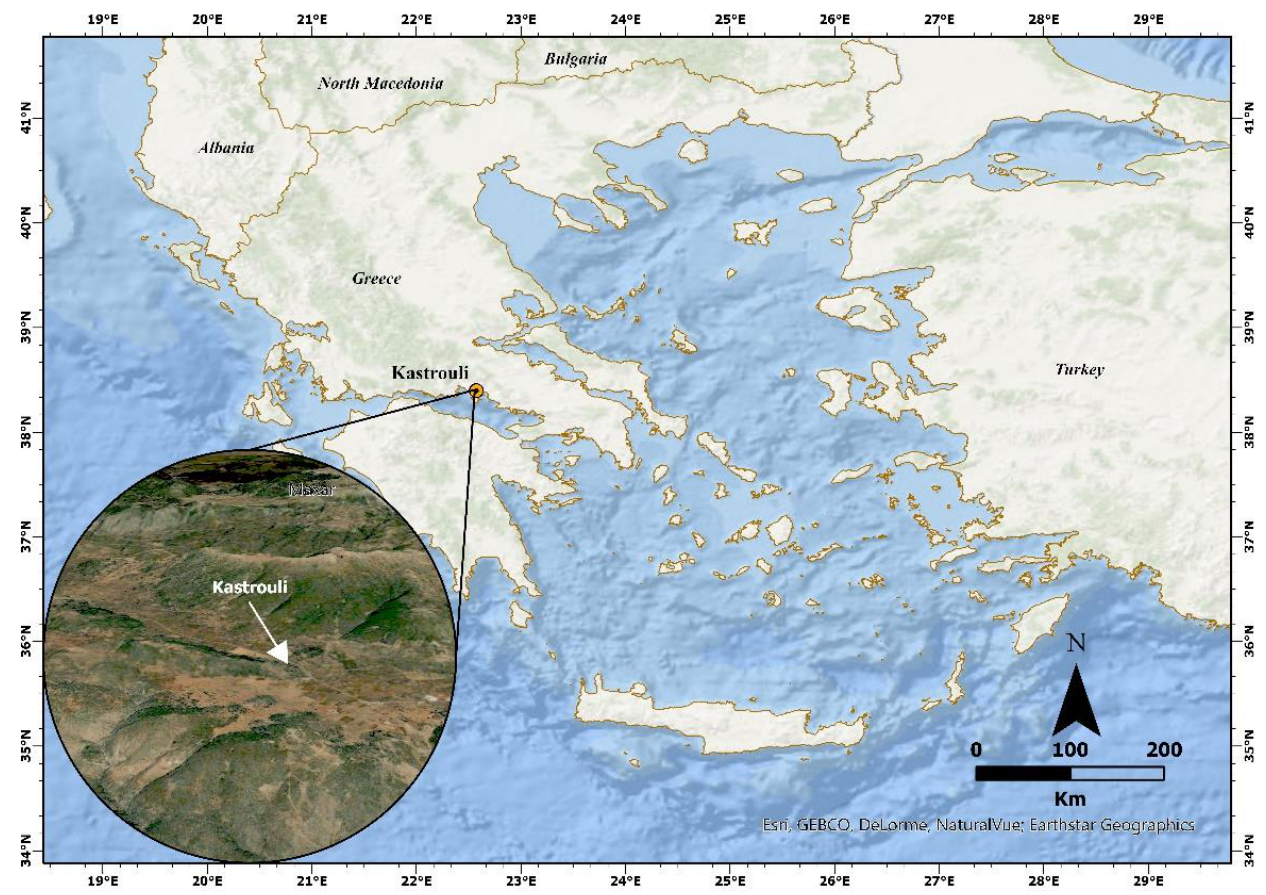
Figure 1. Aerial view of the Kastrouli settlement and environs and the location of the site in the eastern Mediterranean. The traced, shaded landmark on the edge of the plain is noticeable, and it is where water gathers during the winter; this geometric mark indicates plant debris forming a traced boundary of a littoral zone similar to shorelines.